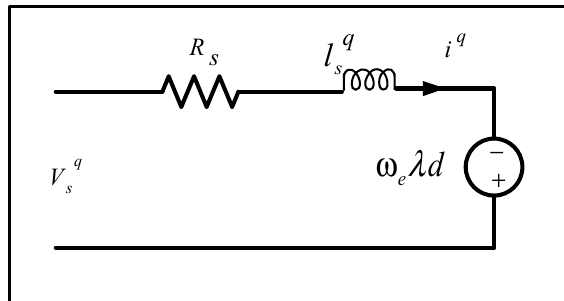
Figure 5. d axis PMSG mathematical model.